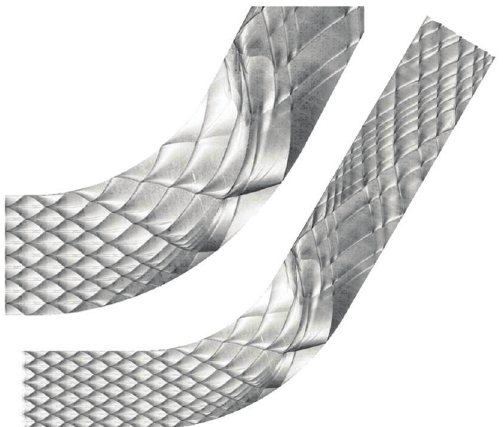
Figure 20: Triple point trajectories for the regular oscillating hydrogen-oxygen detonation propagating through a 60-degree pipe bend of 5 λ . The upper graph is an enlargement of the triple point trajectories in the